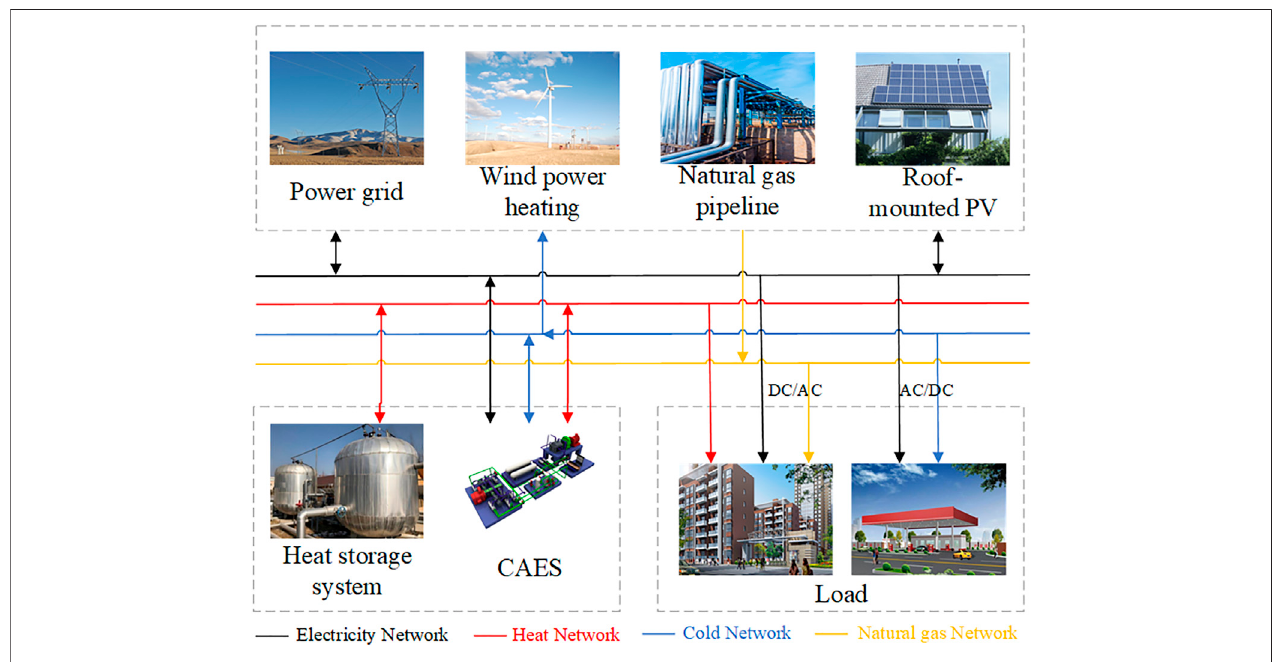
FIGURE 1 | The framework of a micro Energy